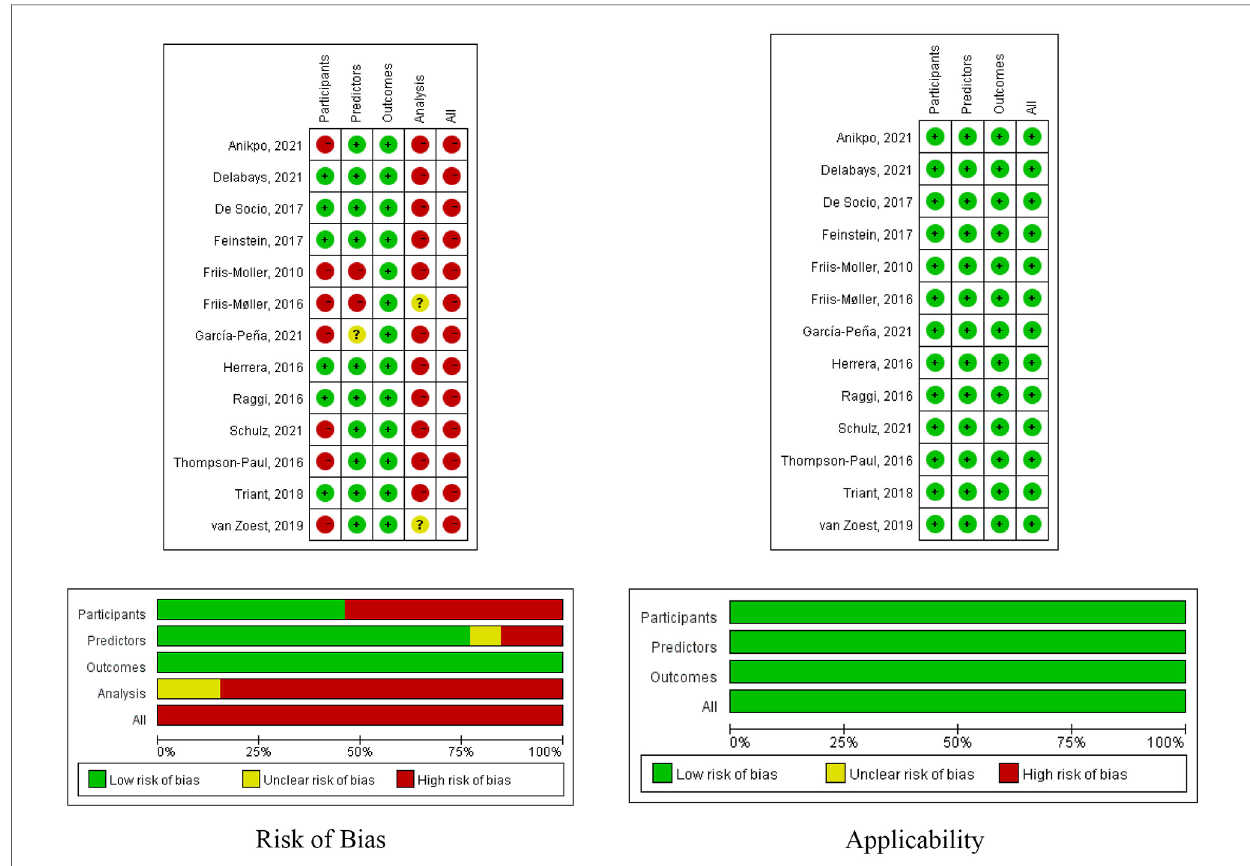
FIGURE 2 Risk of bias and applicability of the included